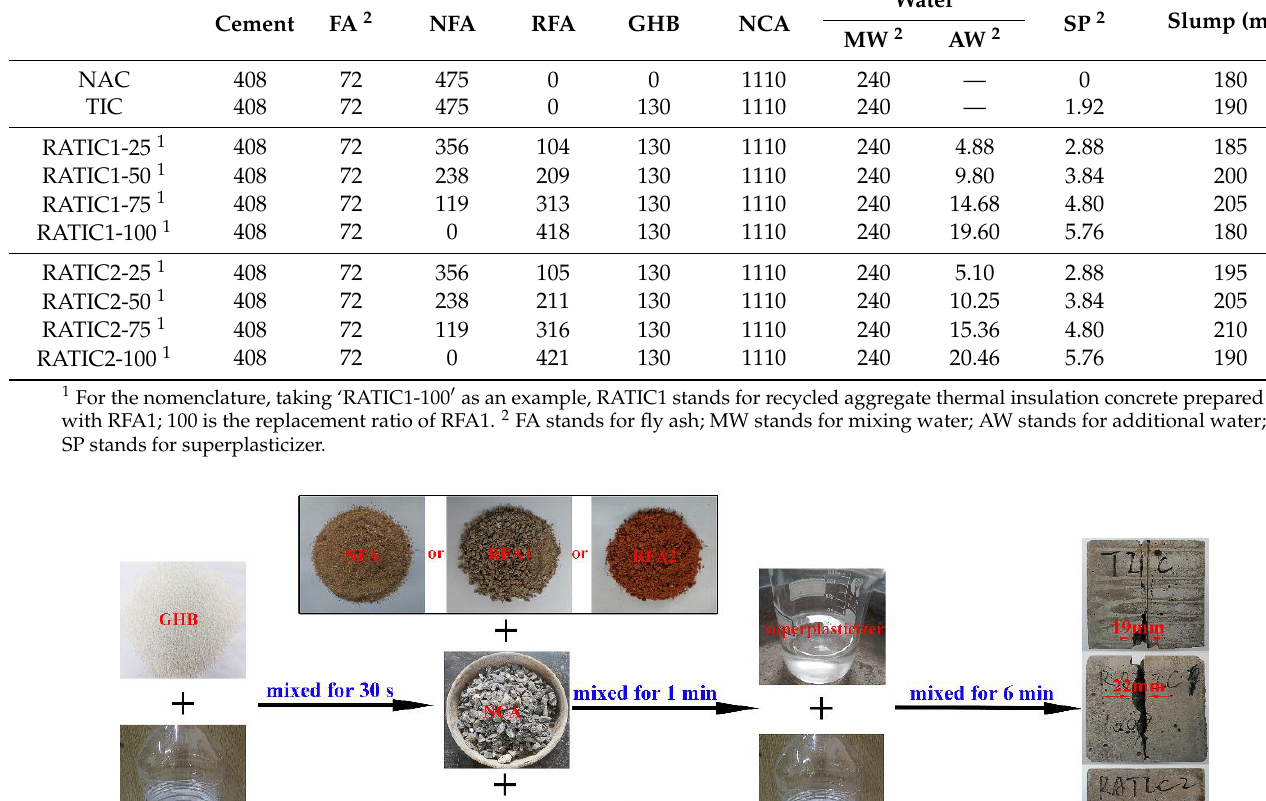
Table 5. Mix proportions of RATIC under different replacement ratio (kg).